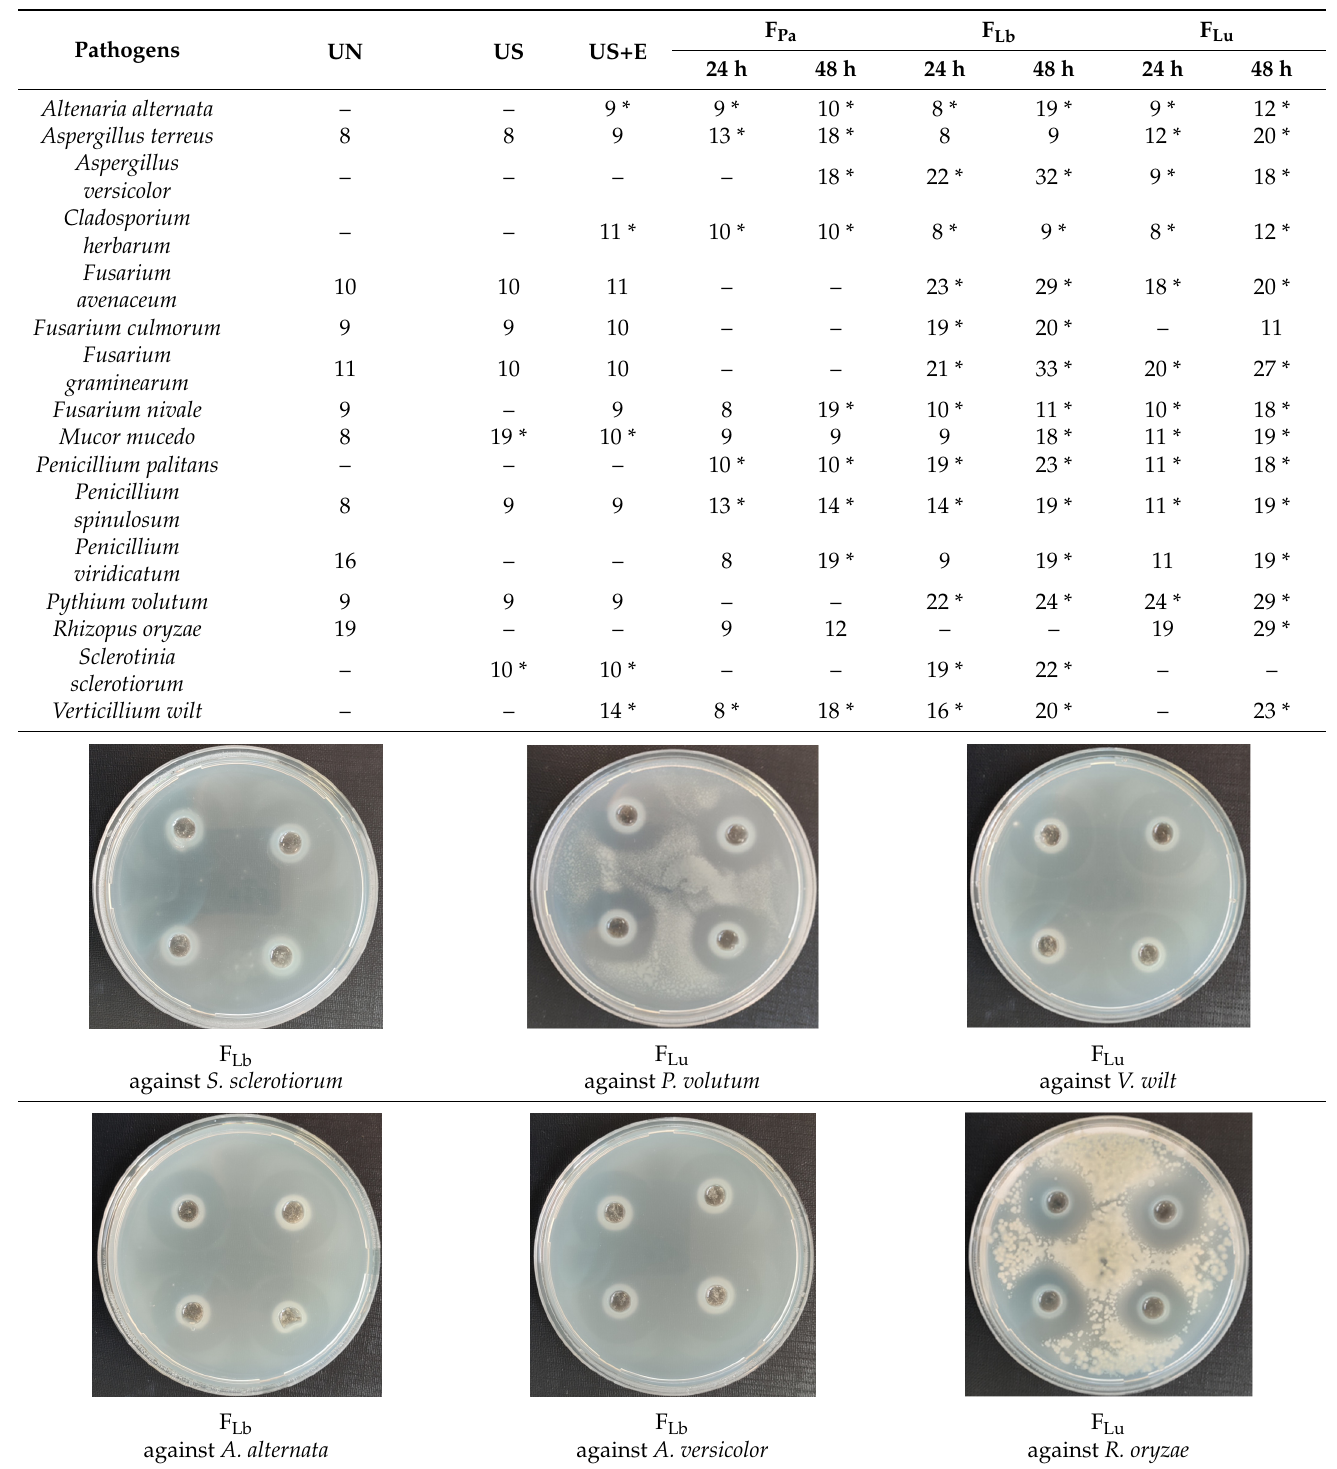
Table 4. The diameters (in mm) of the inhibition zones formed by untreated and pre-treated rice bran extracts against plant